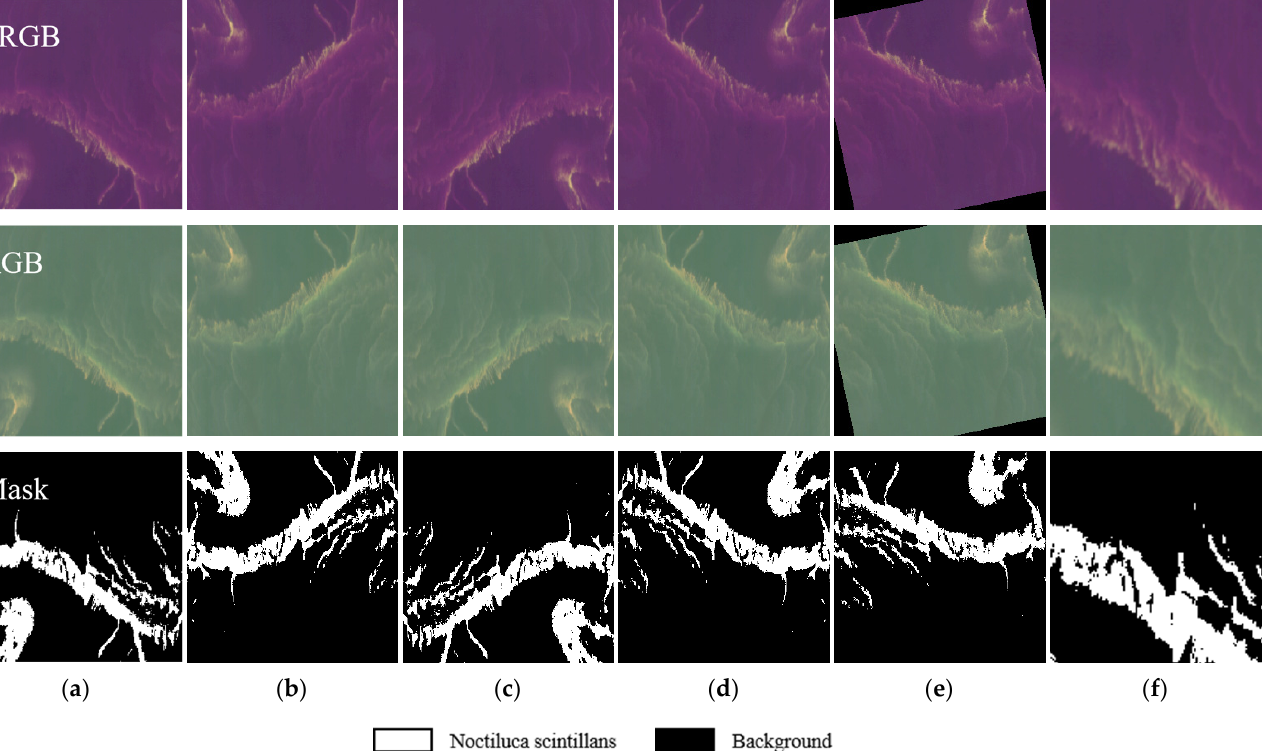
Figure 6. Examples of data augmentation results. ( a ) Origin; ( b ) horizontal flipping; ( c ) vertical flipping; ( d ) diagonal flipping; ( e ) random angle rotation; ( f ) random scale scaling.